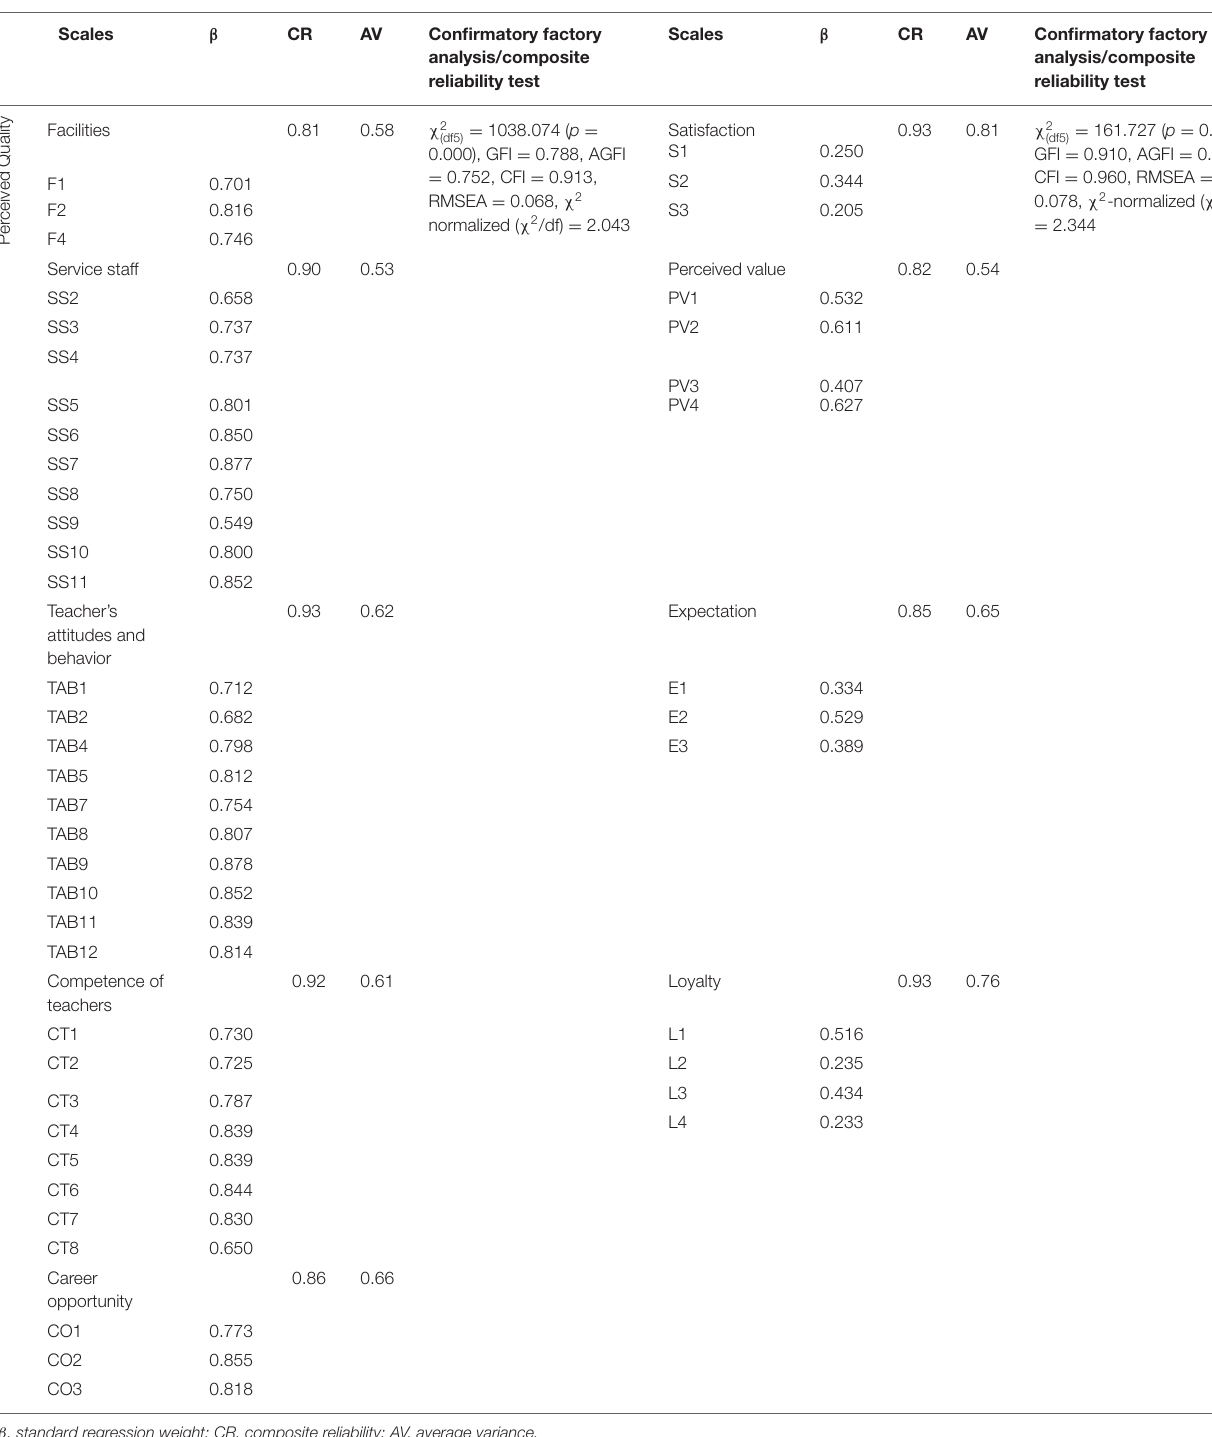
TABLE 3 | Reliability and confirmatory factor analysis. Scales β CR AV Confirmatory factory